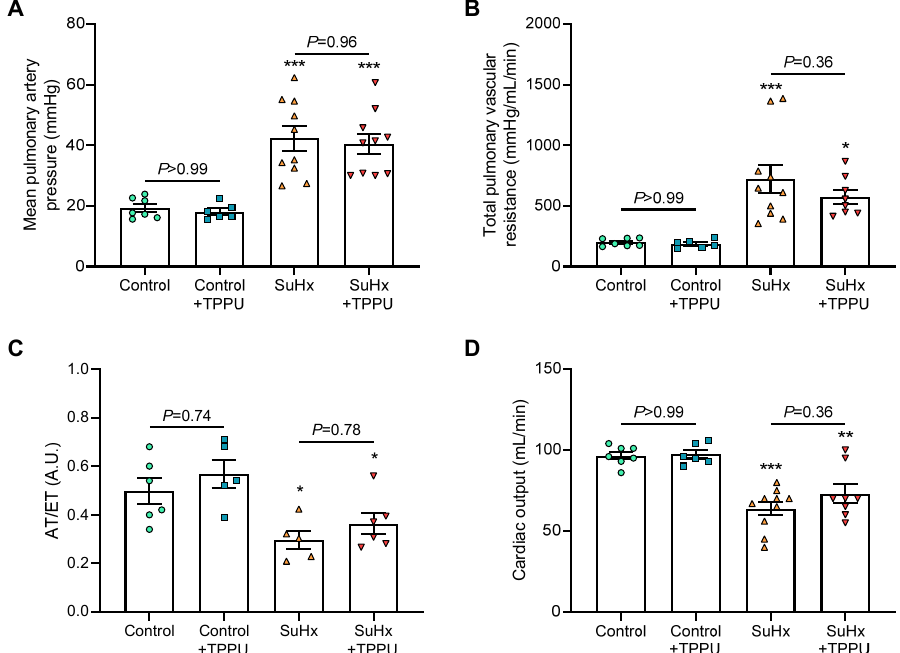
Figure 1. Values of mean pulmonary arterial pressure ( A ), total pulmonary vascular resistance ( B ), pulmonary artery acceleration time to right ventricular ejection time ratio (AT/ET; ( C )), and cardiac output ( D ) obtained in normoxic control rats and in rats receiving Sugen 5416 associated with 3-week hypoxia (SuHx) treated with vehicle or with the soluble epoxide hydrolase inhibitor TPPU. AT/ET was obtained in a subset of animals from each group. Two animals died in the SuHx + TPPU group during hemodynamical measurements before cardiac output and pulmonary vascular resistance could be obtained. * p < 0.05, ** p < 0.01, and *** p < 0.001 vs. corresponding control rats.